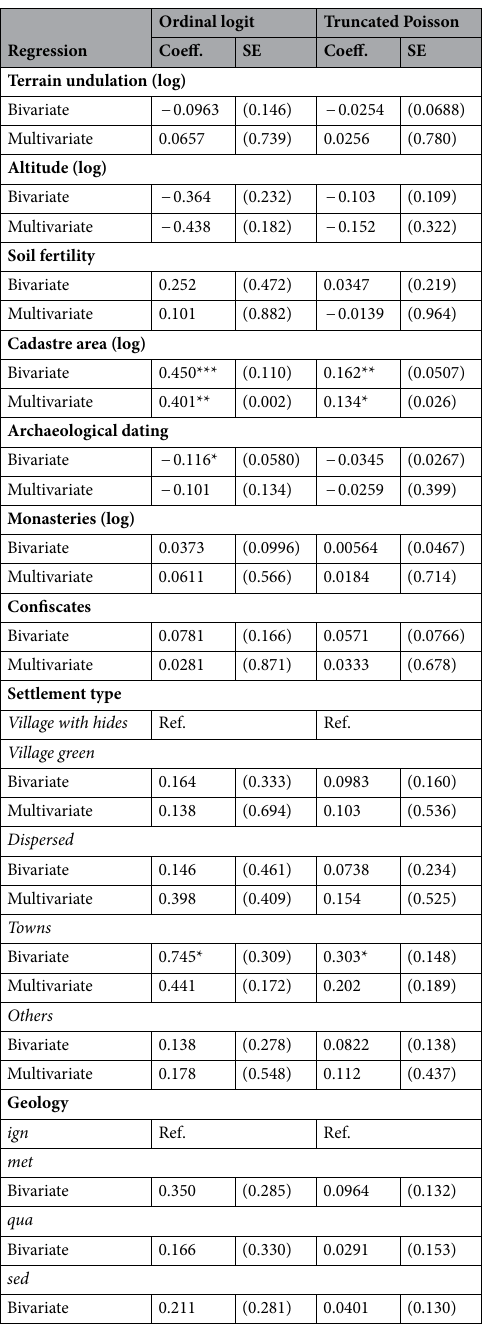
Table 4. Coefficient estimates for bivariate and multivariate regressions explaining field pattern diversity. (i) To enhance readability, archaeological date and soil fertility were divided by 100 prior to running